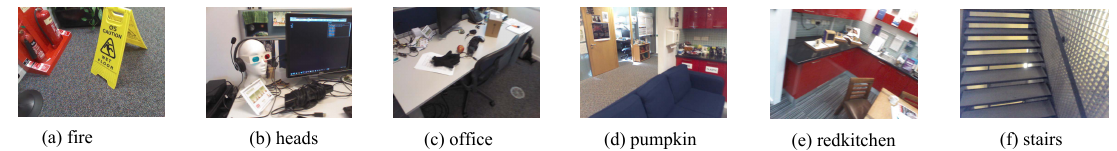
Figure 10. When we performed relocalization in Chess scene, the scene recognition module determined whether the input image belonged to Chess scene, giving the confidence of predicted pose from left to right: 12.3%, 16.5%, 14.4%, 23.3%, 18.6%, 16.6%.